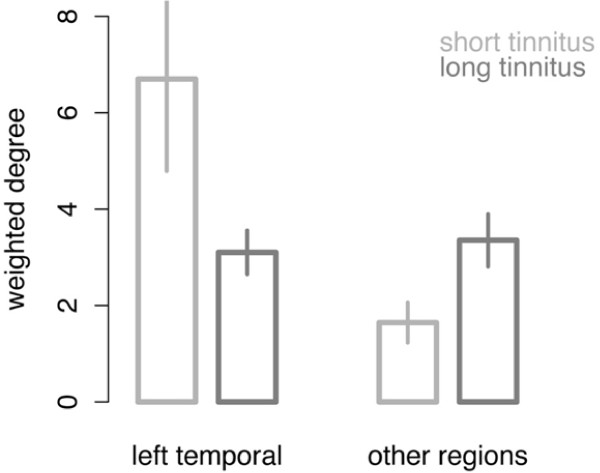
Centrality of the left temporal cortex in the gamma network. As a measure for the centrality of the left temporal cortex we calculated the „weighted degree" for both subgroups by adding the number of links that connect to the left temporal source, weighted by the strength of the connections. The centrality of the left temporal cortex was compared with the centrality of other regions. Error bars indicate the standard error of the mean over the respective tinnitus group.